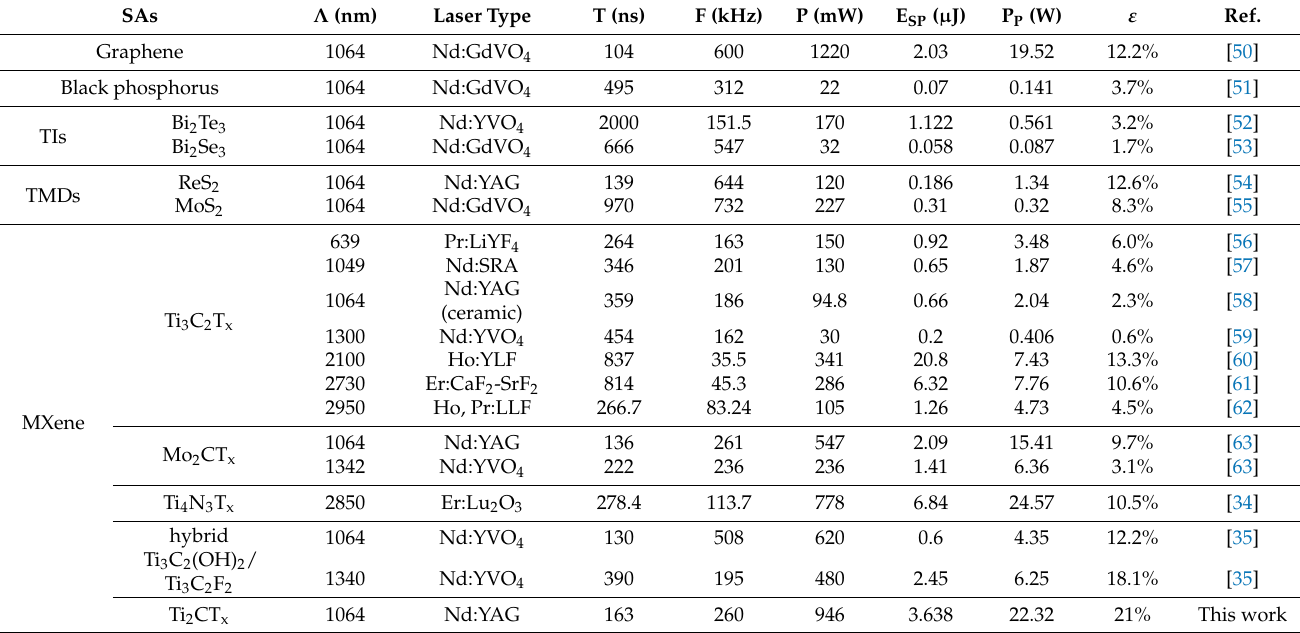
Table 1. Comparison of different 2D materials-SAs used in Q-switched solid-state